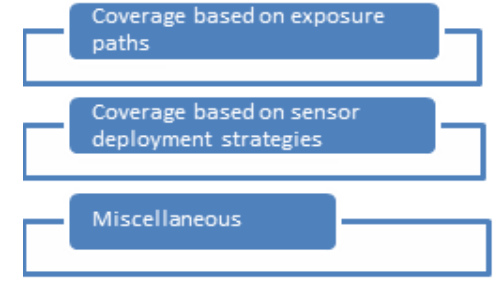
Figure 1. Techniques for optimal network coverage and connectivity. Figure 1. represents the techniques used for